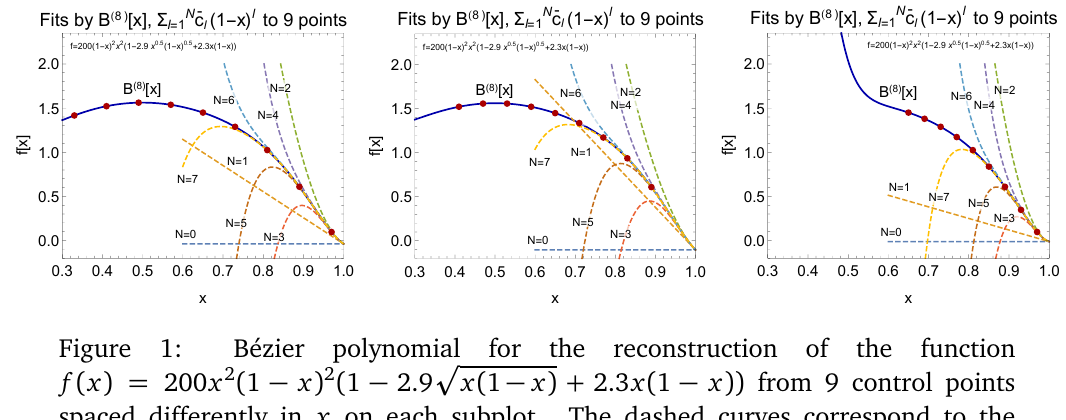
Figure 1: Bézier polynomial for the reconstruction of the function (cid:112) f ( x ) = 200 x 2 ( 1 − x ) 2 ( 1 − 2.9 x ( 1 − x ) + 2.3 x ( 1 − x )) from 9 control points spaced differently in x on each subplot. The dashed curves correspond to the monomial expansions on the right-hand side in Eq. (1) truncated at n = N